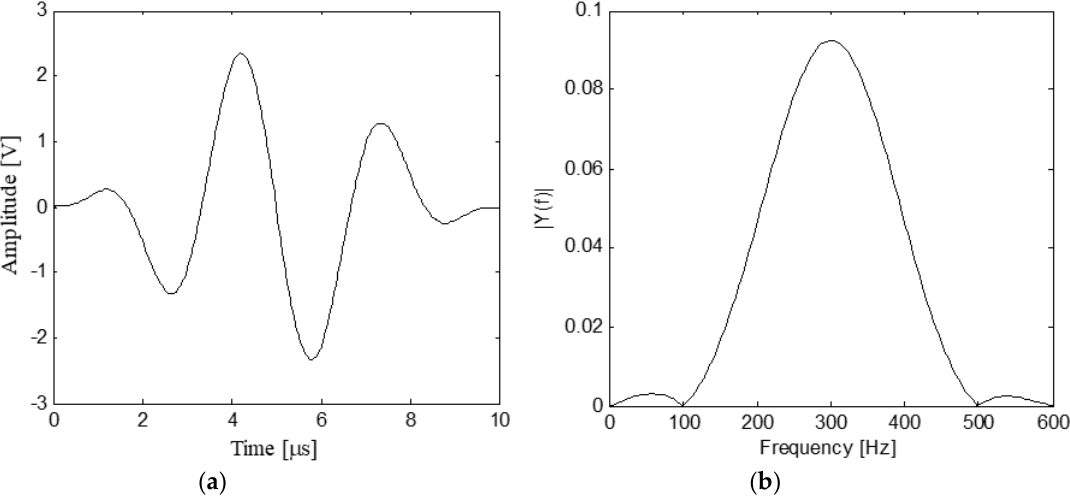
Figure 5. Curves of the excitation pulse in time and frequency domains: ( a ) Time domain; ( b ) Frequency domain.